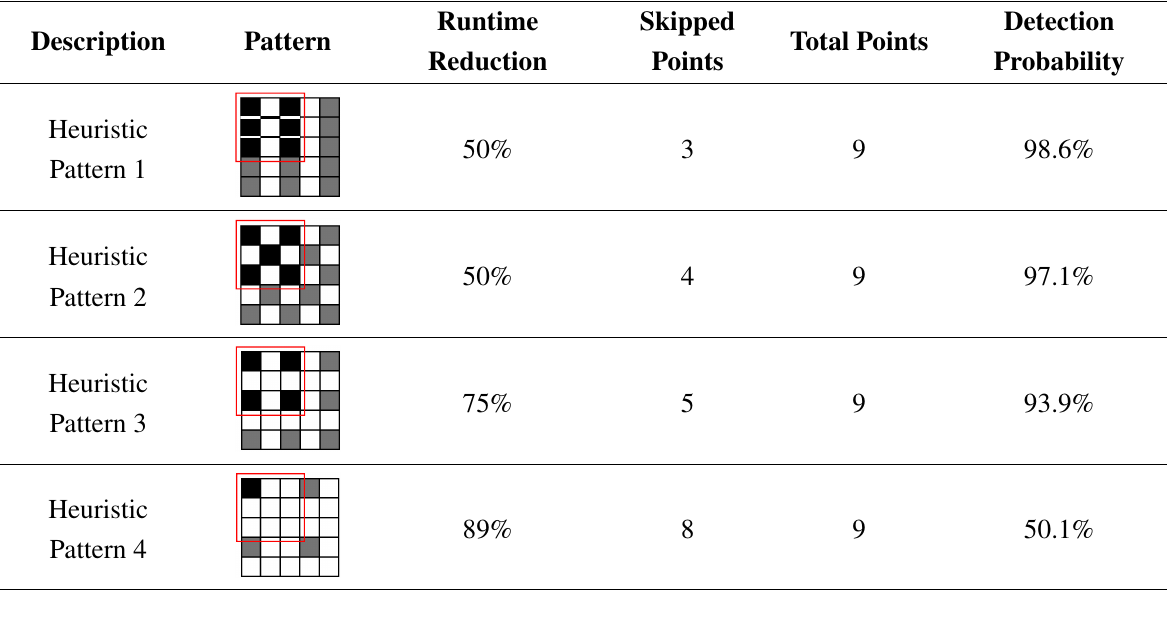
Table 1. Four heuristic patterns for NCC approximation, judiciously chosen to